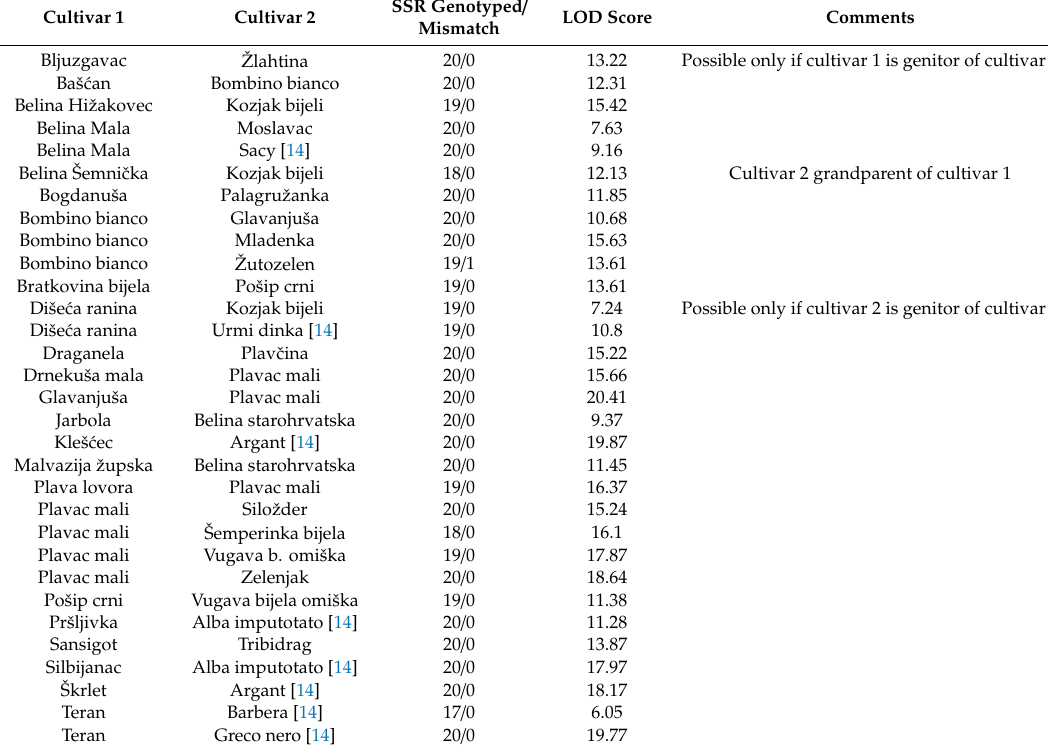
Table 6. Examples of possible direct (first-degree) relationships identified within Croatian grape germplasm using 20